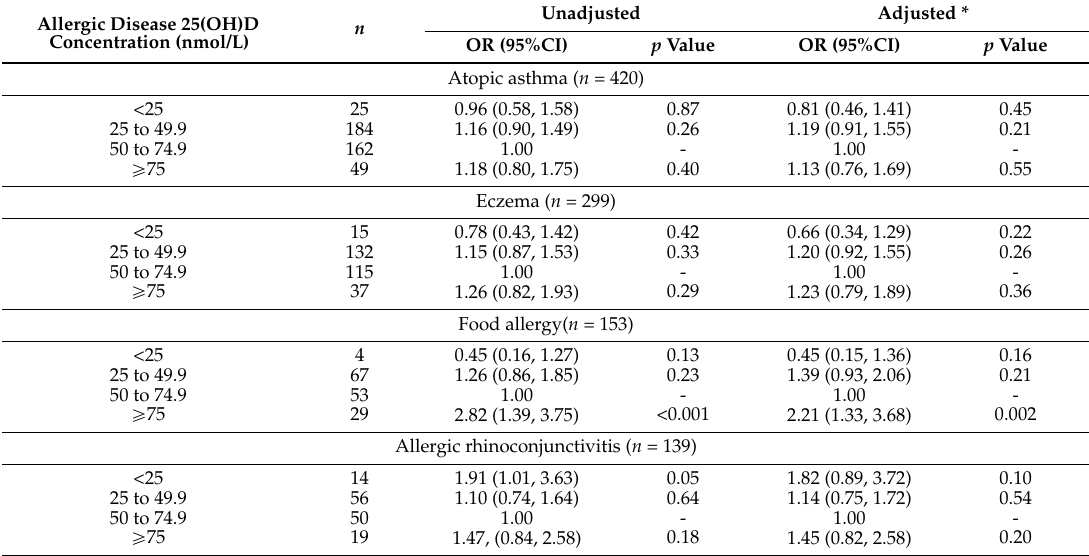
*: Adjusted for gender, ethnicity, skin colour, daycare attendance, vitamin D supplement and toddler milk usage, maternal education level. OR odds ratio, CI confidence interval. No significant difference in mean 25(OH)D concentration was seen for children with and without eczema (53 vs . 52 nmol/L, p = 0.50), allergic rhinoconjunctivitis (52 vs . 52 nmol/L, p = 0.94) and atopic asthma (52 vs . 52 nmol/L, p = 0.98). In contrast, children with food allergy had a higher mean 25(OH)D concentration than those who did not (56 vs . 52 nmol/L, p =